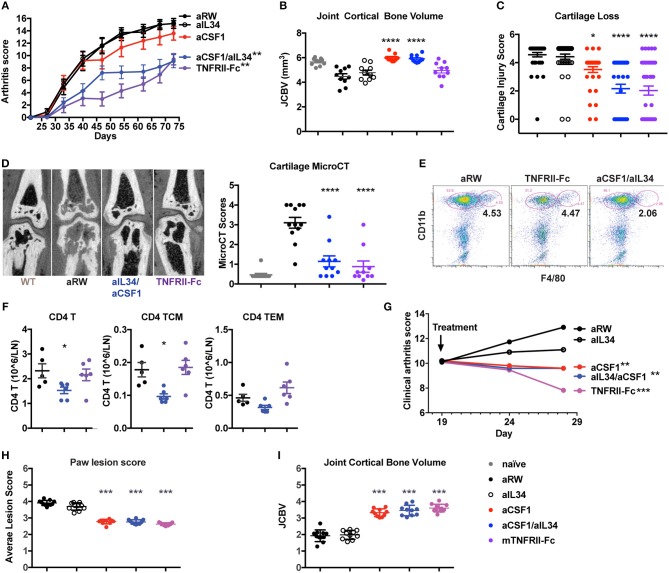
Reduced induced or spontaneous mouse arthritis treated with aCSF1 and/or IL34. (A) Reduced longitudinal clinical score in CIA. DBA/1J mice were randomized at day 24 and then treated with aIL34 and/or aCSF1 for 7 weeks. Murine TNFRII-Fc decoy was used as a standard of care control. Isotype control includes anti-ragweed (aRW). Mice were examined weekly for joint inflammation in each paw. (B) Joint cortical bone volume (JCBV) determined by micro-CT (μCT) was used to quantify bone remodeling at the base of metatarsal bones. One hundred percent bone volume was set for naive mice. Anti-RW control group had lowest JCBV (average 79%) due to the bone erosion. TNFRII-Fc improved it to 87% and aIL34 to 84%. aCSF1 or dual aCSF1/aIL34 maintained the bone volume at a healthy level (106 and 104%). (C) Cartilage injury histology score (n = 38–40/group). (D) Analysis of cartilage damage by contrast-enhanced μCT imaging. Representative micro-CT images shows cartilage as dark rim at joint surface (left set of images). The cartilage scoring system employed a score range from 0 to 4 with the following scale: 0—thick continuous, 1—thick discontinuous, 2—thin continuous, 3—thin discontinuous, 4—no cartilage. All the five MTP joints were individually scored and averaged to get the total score per paw. The total cartilage score per mouse was obtained by averaging the total scores of both the hind limb paws (n = 6 per group). Anti-CSF1 or anti-IL34 monotherapies were not tested in this study. (E) Joint inflammatory CD11b+F4/80+ macrophages are reduced with aCSF1/aIL34 treatment. Arthritic mice, with a disease score of 4, were randomized and received anti-IL34/anti-CSF1, aRW, or TNFRII-Fc for 7 days. Ankle joints were harvested and processed for FACS. Each data point represents samples pooled from three mice. (F) Reduced CD4 T central memory (TCM) and in draining lymph nodes. (G) TNFΔARE spontaneous arthritis, anti-CSF1 significantly reduces clinical arthritis score. (H) TNFΔARE arthritis paw lesion histology score is improved by aCSF1. (I) TNFΔARE arthritis JCBV is improved with aCSF1. Data are displayed as mean ± SEM. *p < 0.05, **p < 0.01, ***p < 0.001, ****p < 0.0001.